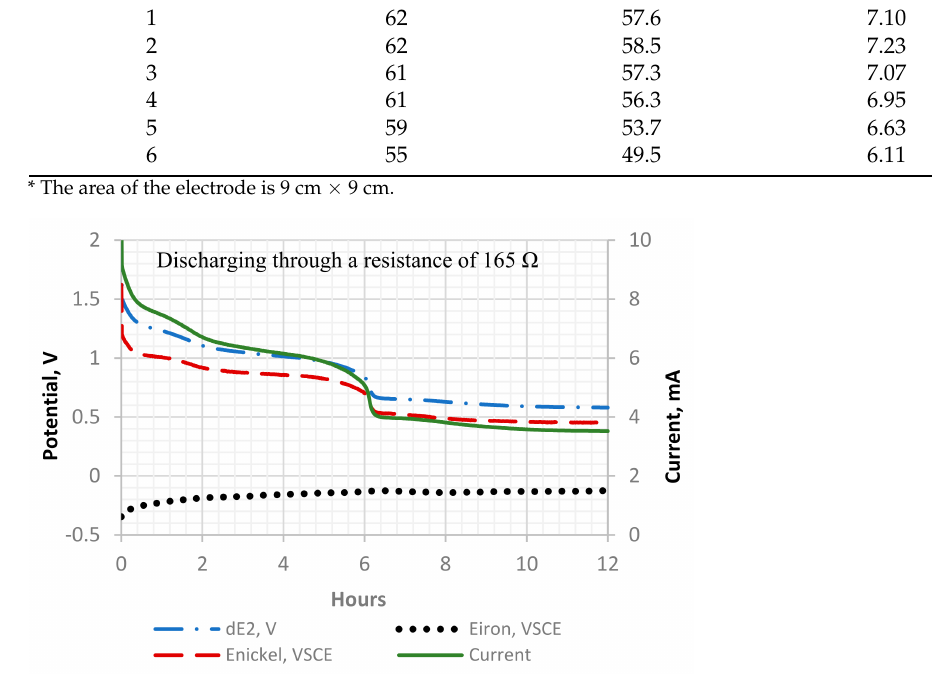
Figure 13. A detailed potential and current development of discharge cycle one. The cell potential is represented by dE2, which is the potential difference between the Ni cathode and the Fe anode.